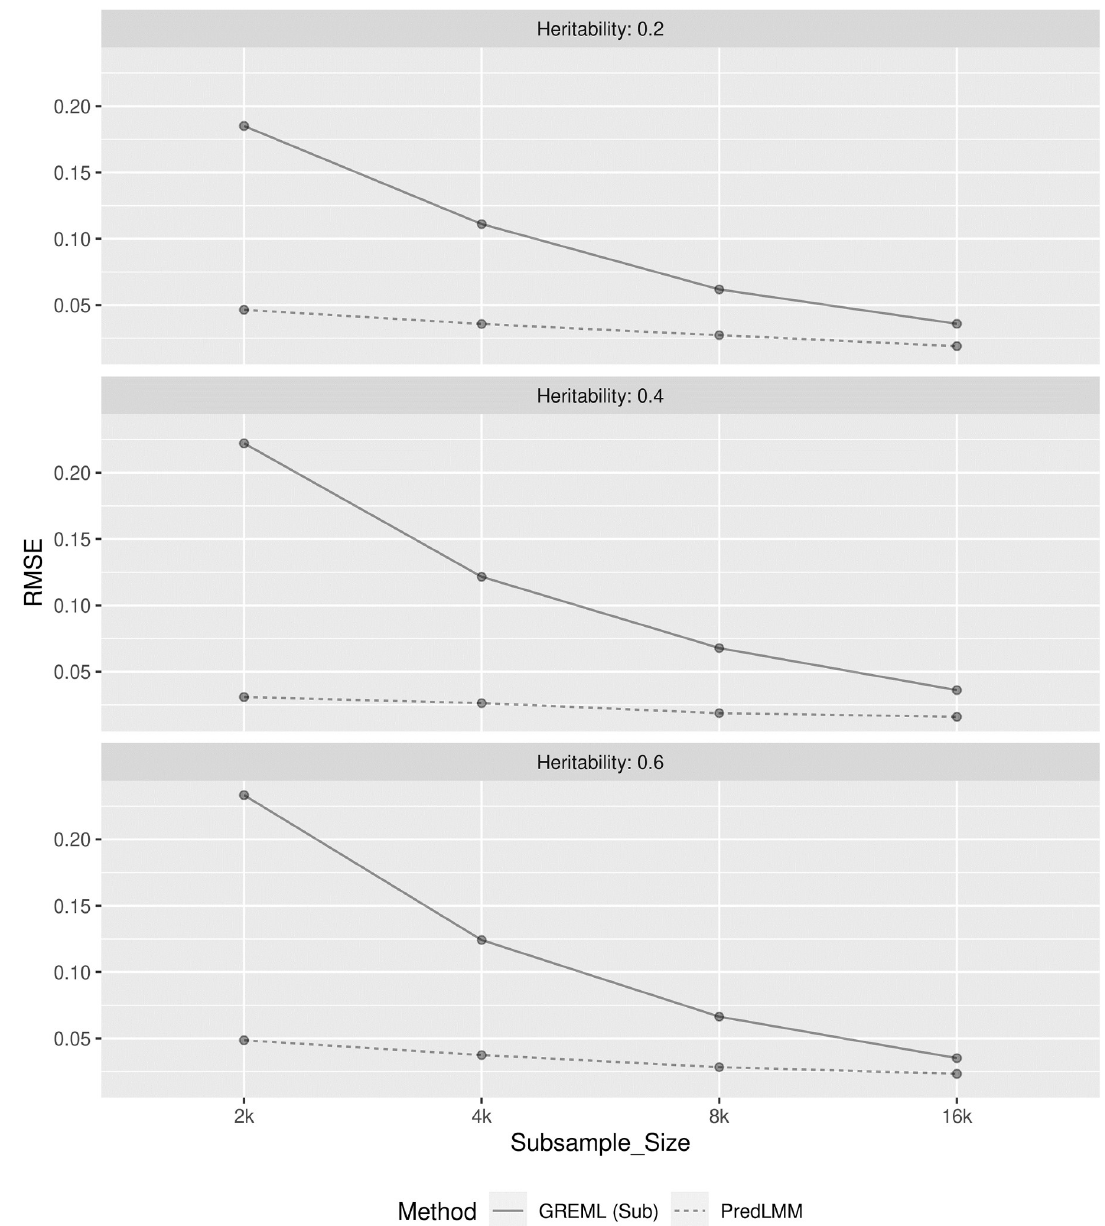
Fig 5. The figure shows the empirical RMSE of GREML (sub) and PredLMM for four different sub-sample sizes: 2000, 4000, 8000, 16000 in cases (a), (b) and (c) from Simulation Study (2.2). For every case, 100 replications were considered. GREML (sub) had very high RMSE for smaller knot-sizes and it became increasingly closer to PredLMM as the knot-size increased.